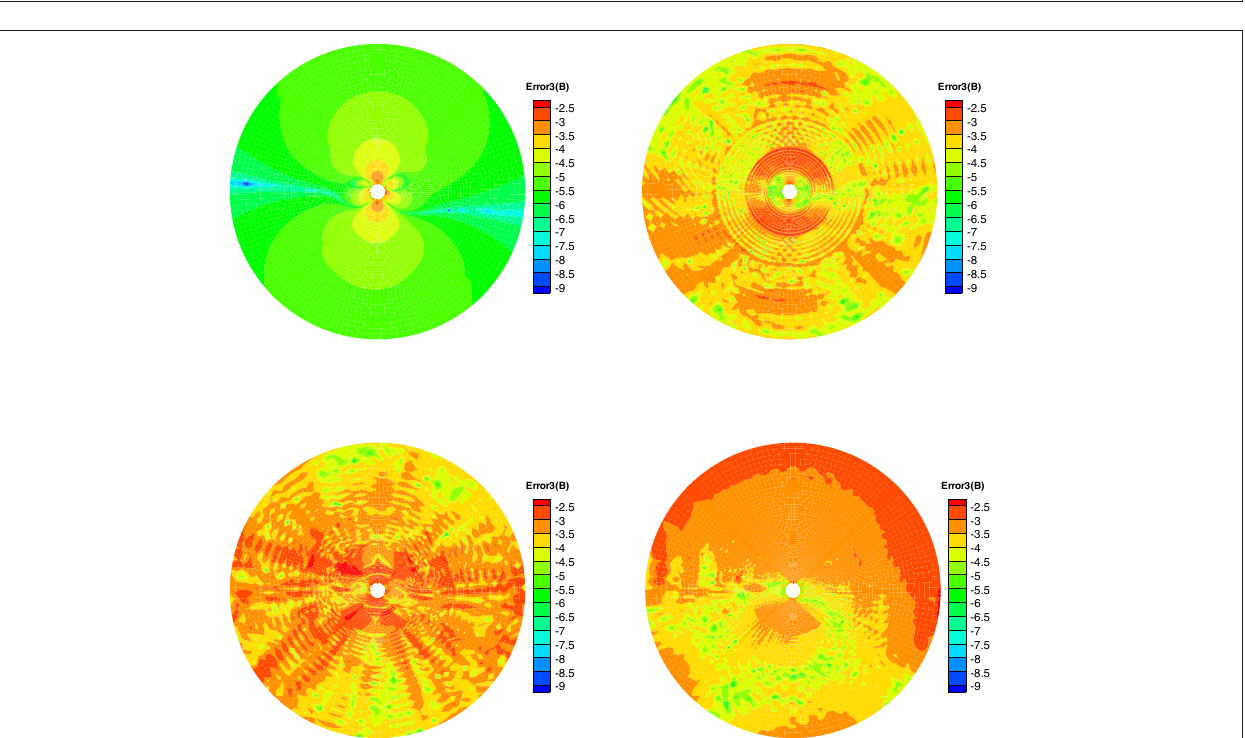
FIGURE 12 | The log 10 Error3 (B) in the calculation at t = 20h on the meridional plane of φ = 180 ◦ − 0 ◦ from 1 to 20 R s , the results from CT method (left) and diffusive method (right) are displayed in the top row, the bottom row is produced from the projection method (left) and GLM method (right).